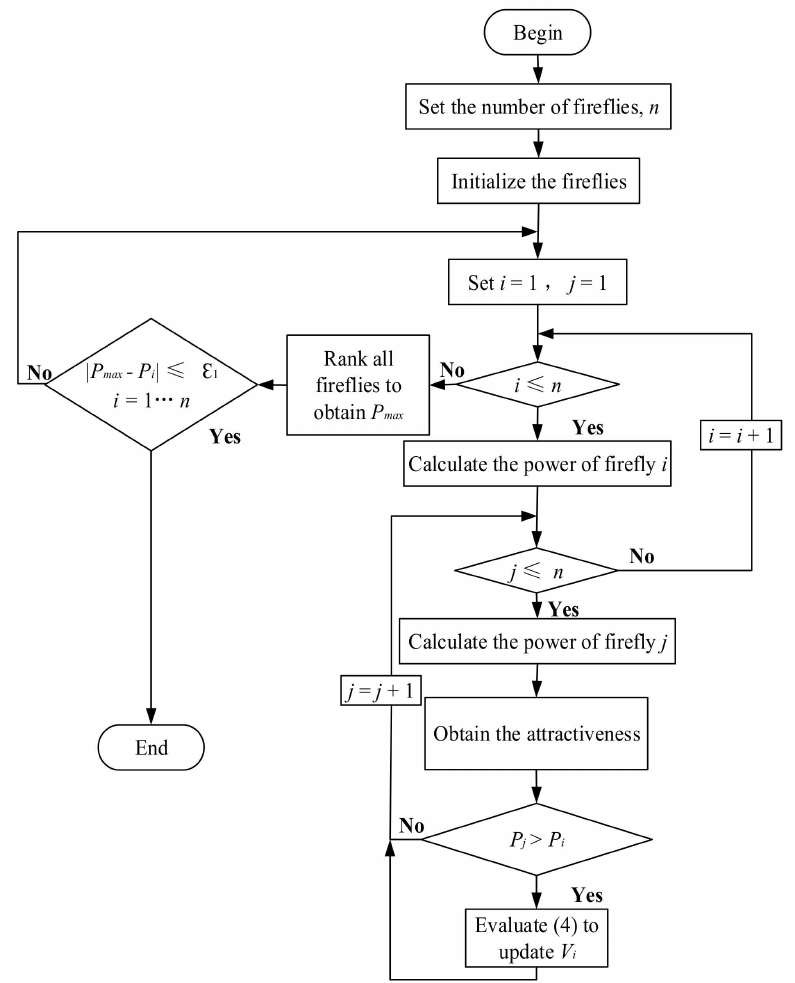
Figure 1. Flow chart of firefly algorithm